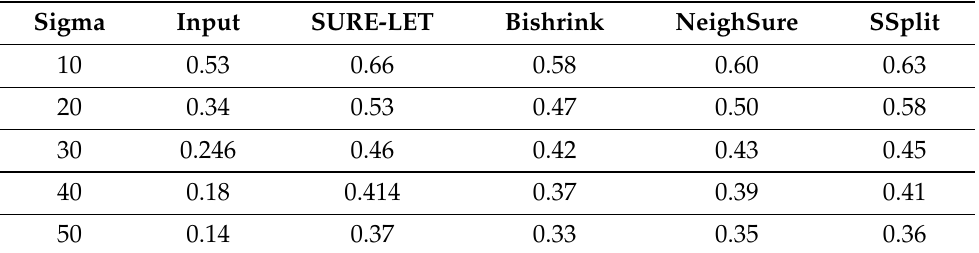
Table 3. Comparison of the proposed methods with the other wavelet-based image denoising methods on the ‘Lena’ image in terms of the structural similarity (SSIM) for a range of input noise levels σ = 10 to σ = 50